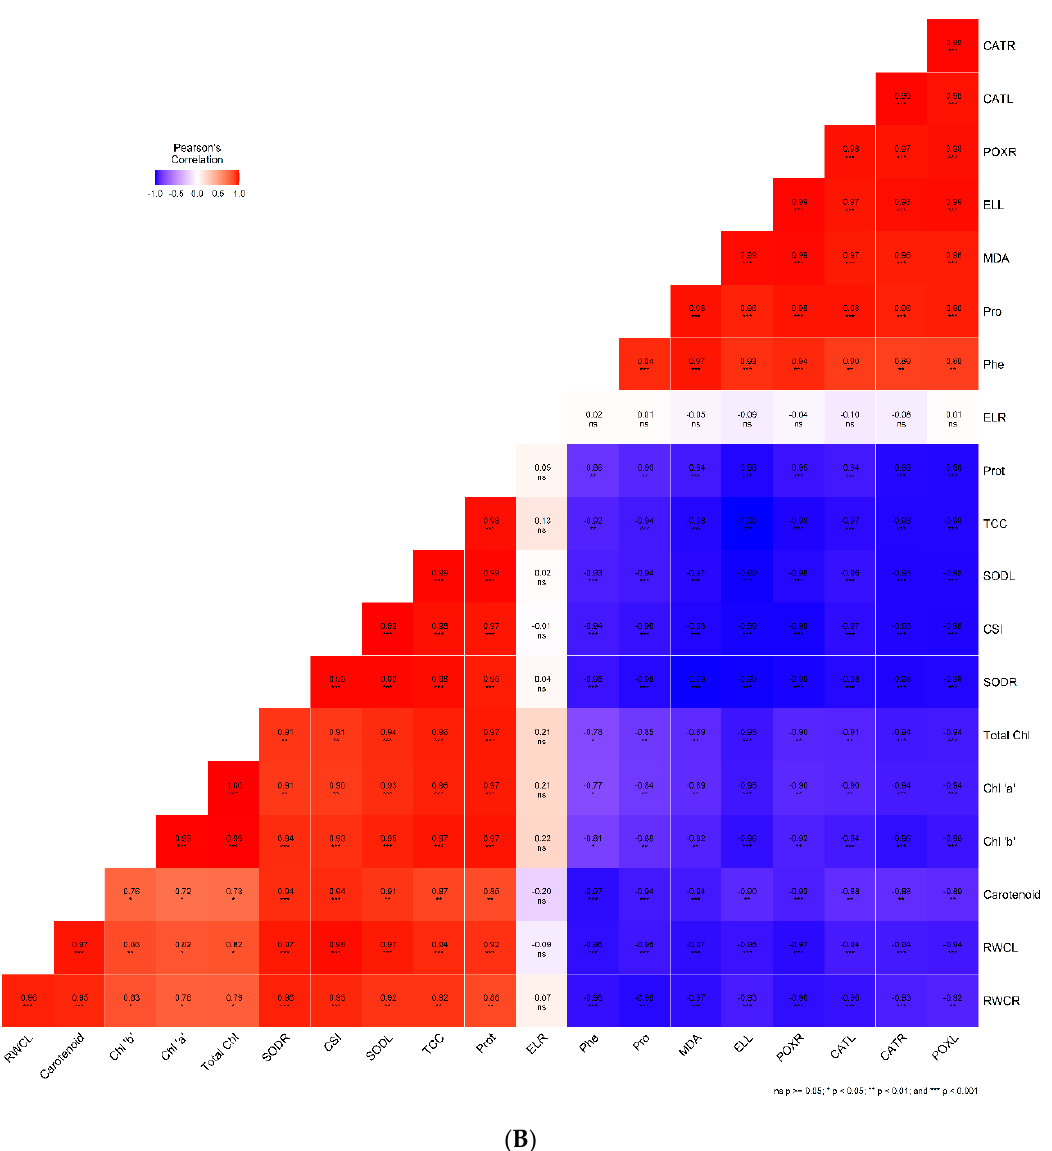
Figure 5. Correlation between different physiological and biochemical parameters, photosynthetic pigments, and antioxidant enzyme activities of KRL-210 ( A ) and WH-1105 ( B ) under different salinity levels with Si treatment (* p < 0.05, ** p < 0.01, *** p < 0.001). The abbreviations used in the